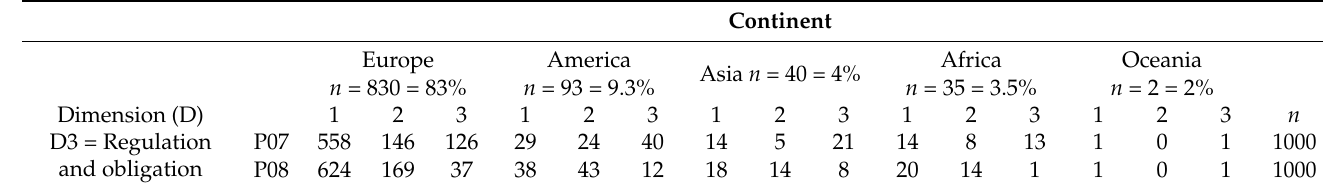
Table 11. Count by continent of the participating sample for dimension D3.